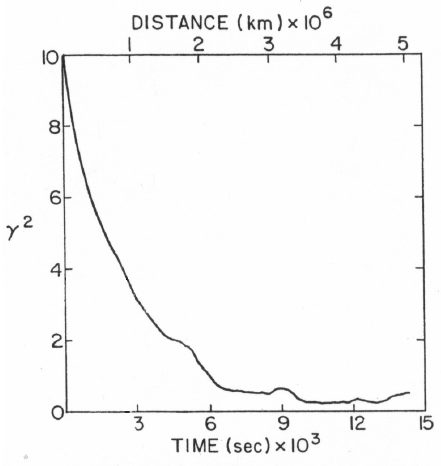
Figure 115: Magnetic field auto-correlation function at 1 AU. Image reproduced by permission from Matthaeus and Goldstein (1982b), copyright by